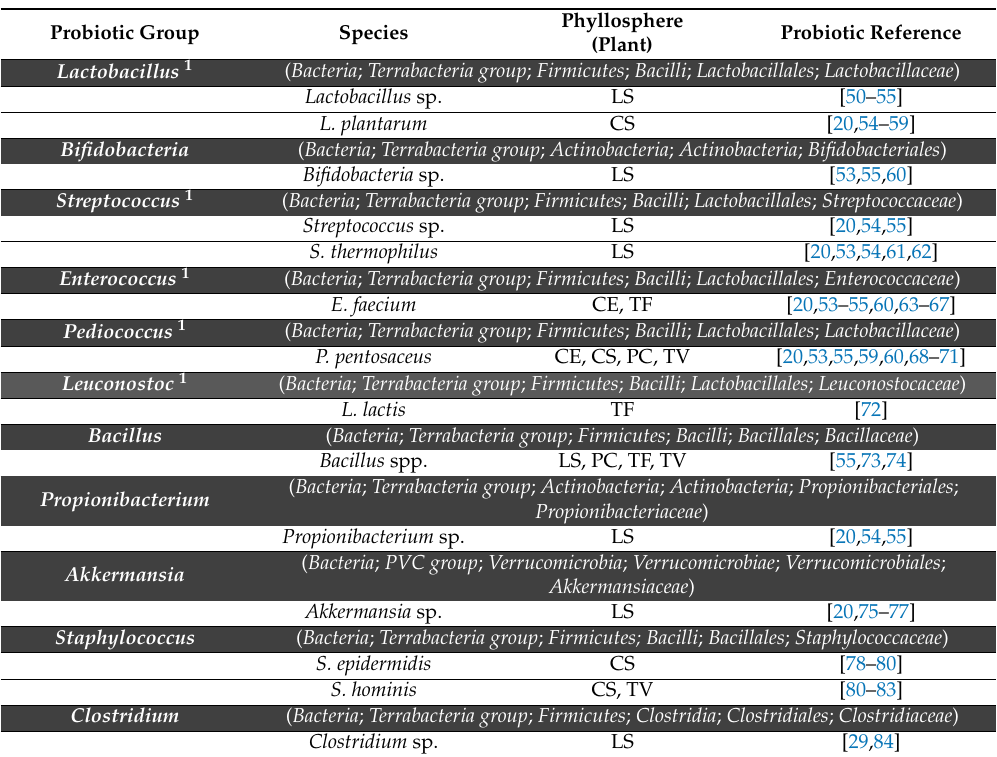
Table 3. Potential probiotic bacterial species detected in the phyllosphere of raw eaten produce of the present study. Related references demonstrate the verified probiotic character of the strains of the same